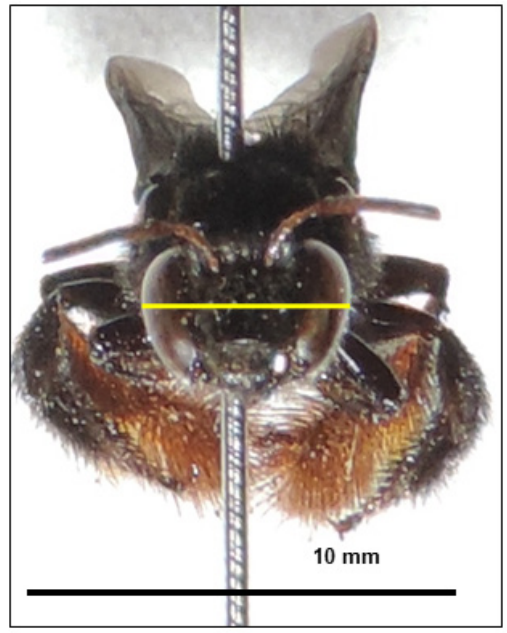
Fig 1. Measure of the head maximum width of Tetrapedia curvitarsis